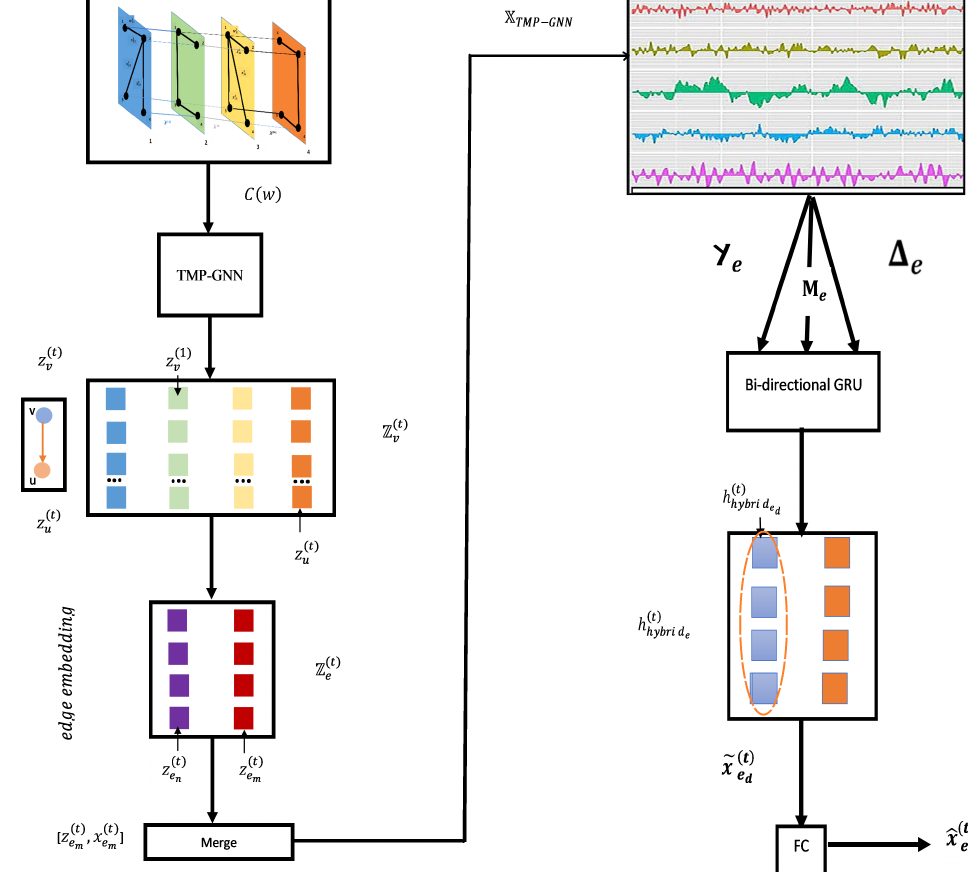
Figure 4. E-TMP-GNN